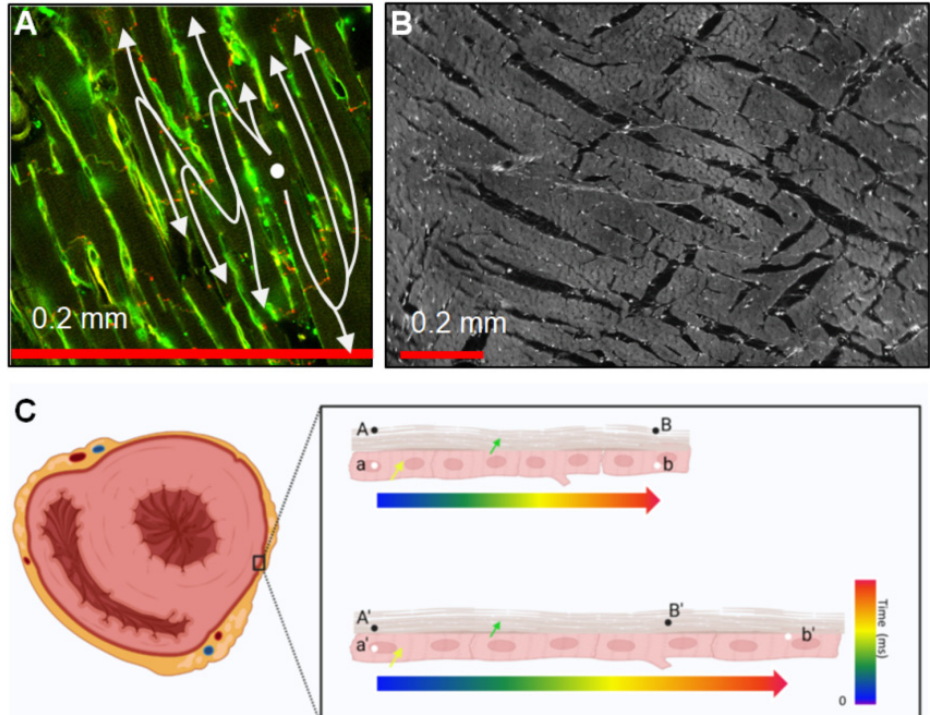
Figure 1. Structure and mechanical considerations affecting CV measurements. ( A ) Cell-to-cell connectivity through intercalated disks located at cell endpoints causes a ‘zig-zag’ conduction in the trans-cell direction that increases path lengths and slows the apparent (extrinsic) conduction [9]. The image shows rat ventricular tissue labeled with wheat-germ agglutin (green) and Cx43 (red). ( B ) Layers are approximately 5–6 cells thick and form laminae orthogonal to the cell long axes. These can also cause increased activation path lengths due to indirect conduction at this scale [10]. The image shows midwall tissue from a rat’s left ventricle. ( C ) Extrinsic and intrinsic CV. The left panel shows a pattern of ventricular transverse sections. The yellow arrow indicates localized cardiomyocytes, and the green arrow shows epicardium. A/A’ and B/B’ indicate spatially fixed points between which the extrinsic CV is measured; a/a’ and b/b’ indicate defined points of the tissue between which the intrinsic CV would be assessed. The top right panel indicates that in the un-stretched myocardium, B and b are depolarized at the same time (intrinsic = extrinsic CV); in the bottom right panel, assuming that the intrinsic CV remains constant, extrinsic CV would appear to be increased as tissue at B’ completes depolarization at an earlier time.